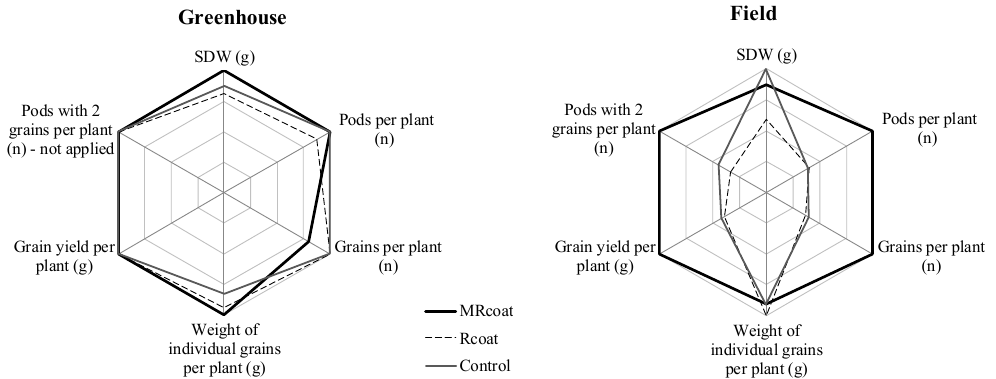
Figure 1. Representation of productivity parameters of chickpea in different inoculation treatments (control, Rhizophagus irregularis (Rcoat), a mixture of R. irregularis isolates (MRcoat)), under greenhouse and field conditions. Radial graphs represent results relative to the higher value (indicated as 100%) for each productivity parameter.